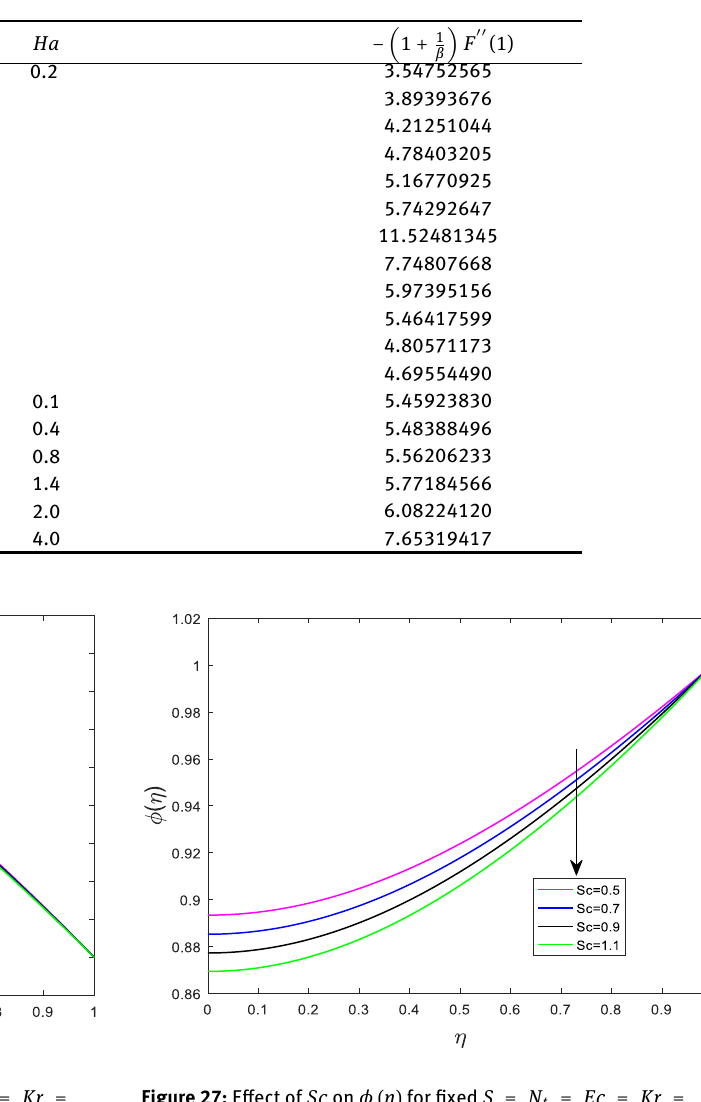
Figure 26: Effect of Sc on θ ( η ) for fixed S = N t = Ec = Kr = 0.1, Ha = N = β = Ω = Ω = 0.5 and Pr = 0.7 T C b